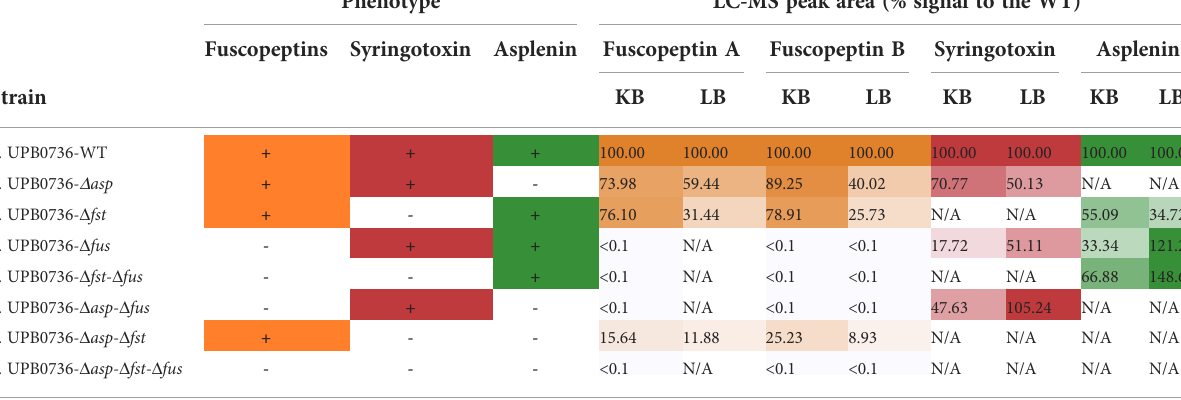
TABLE 3 CLP quanti fi cation in Pseudomonas fuscovaginae UPB0736 WT and CLP mutants by LC-MS/MS.